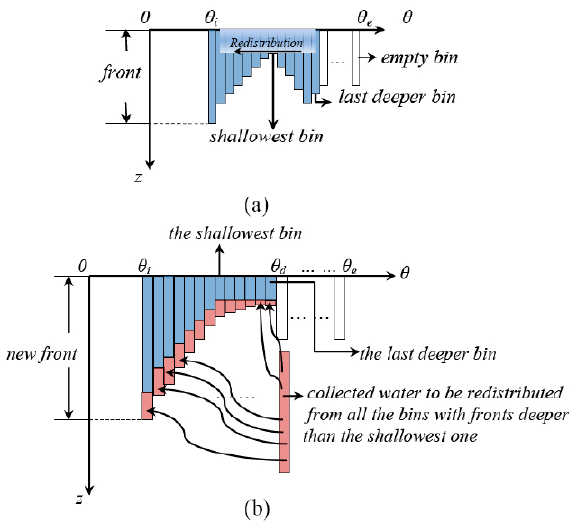
Figure 3. The redistribution in the Talbot–Ogden model: ( a ) pre-redistribution and ( b ) post- redistribution.